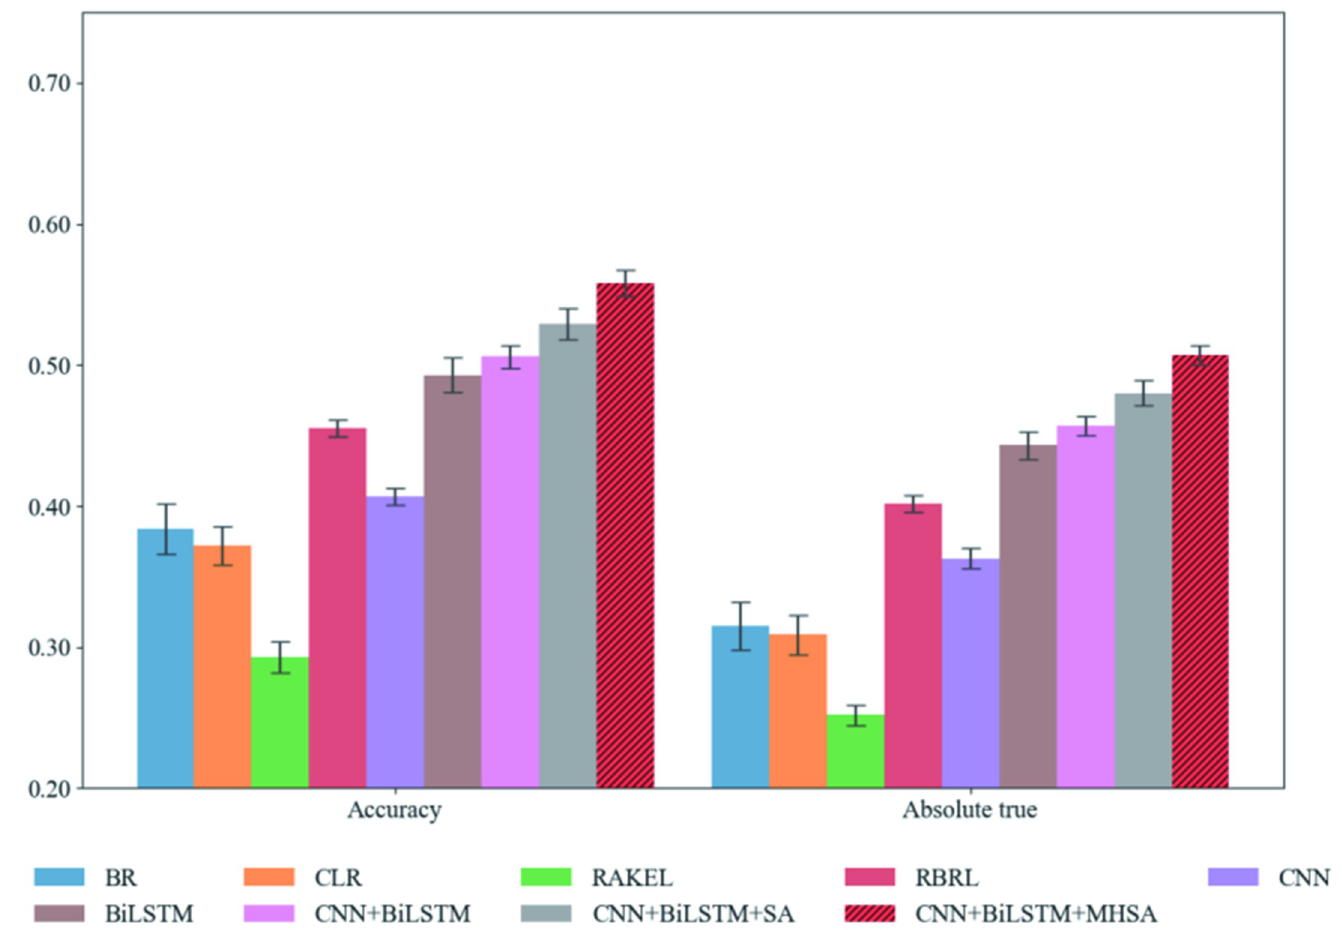
Fig 2. Accuracy and Absolute true of multi-label therapeutic peptides prediction models using different classical ML and DL algorithms on the training set with 5-fold cross-validation.